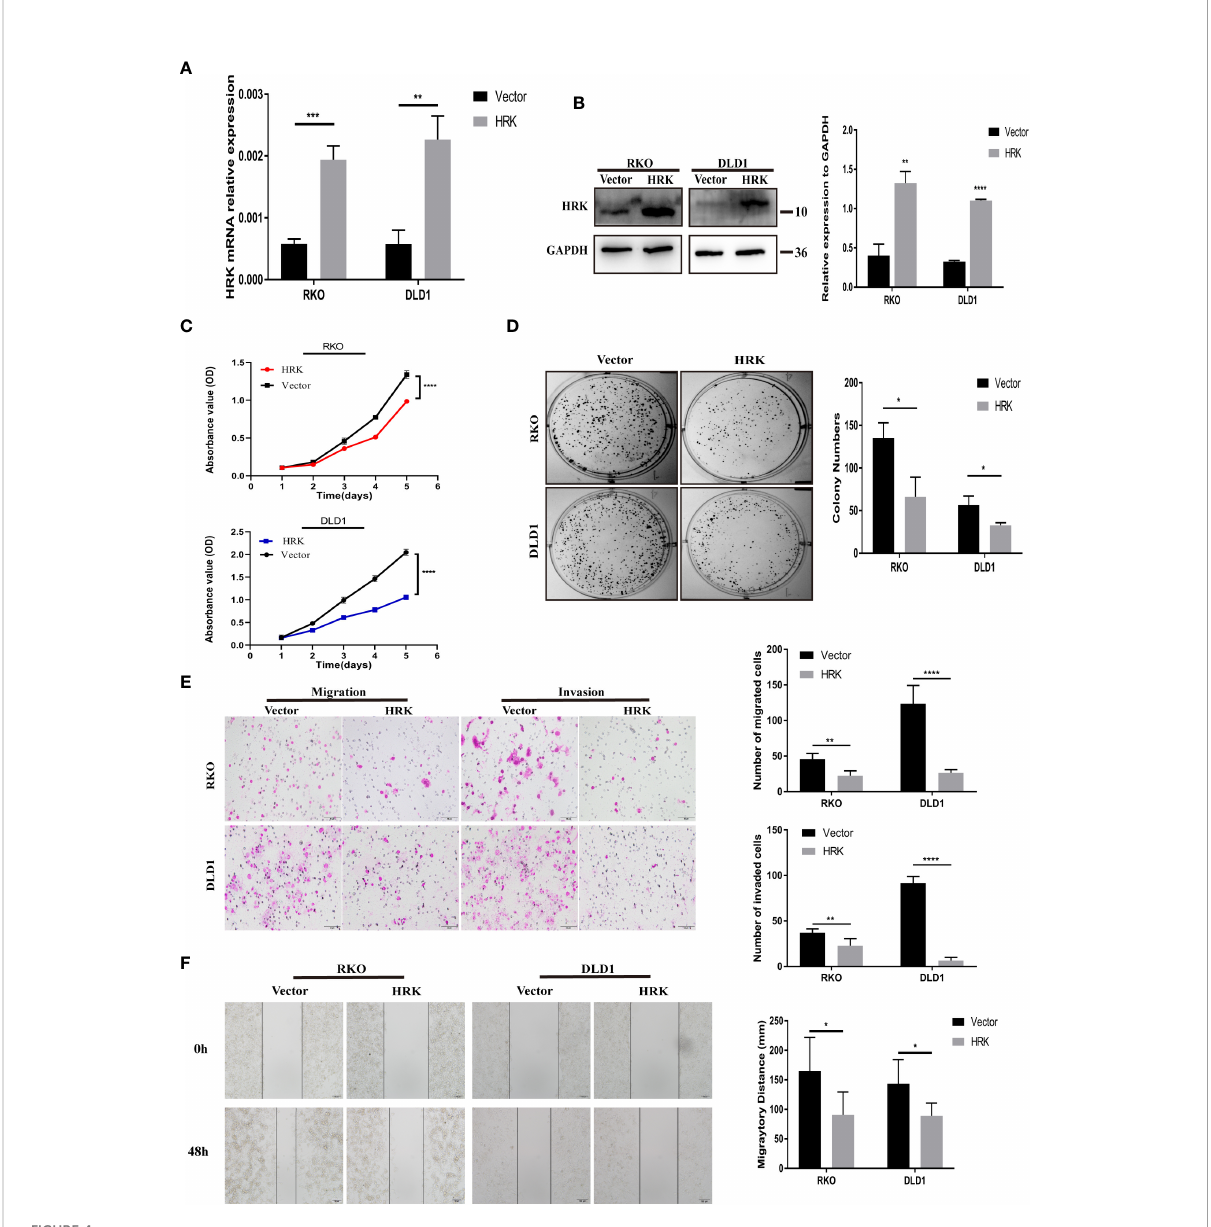
FIGURE 4 HRK overexpression reduces CRC cell proliferation, migration, and invasion in vitro . (A, B) , Overexpression of HRK after transfection of the pcDNA3.1-HRK or pcDNA3.1 plasmids was con fi rmed in 2 CRC cell lines by Real time RT-PCR and Western blotting. (C, D) , Effects of HRK overexpression on CRC cell proliferation by CCK-8 (C) and colony formation assays (D, E) , Matrigel transwell assays were used to determine the invasion ability of HRK-overexpressed CRC cells. Matrigel-free transwell assays showing the migration ability of HRK-overexpressed CRC cells. (F) , The effects of HRK overexpression on the migration abilities of CRC cells by using wound-healing assay. Data are expressed as the means ± SD in 3 independent experiments. * P < 0.05, ** P < 0.01, *** P < 0.001 and ****P